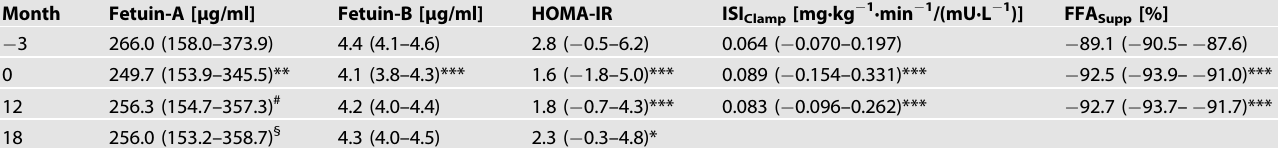
Table 2. Fetuin-A and B levels and tissue-speci fi c insulin sensitivity during the